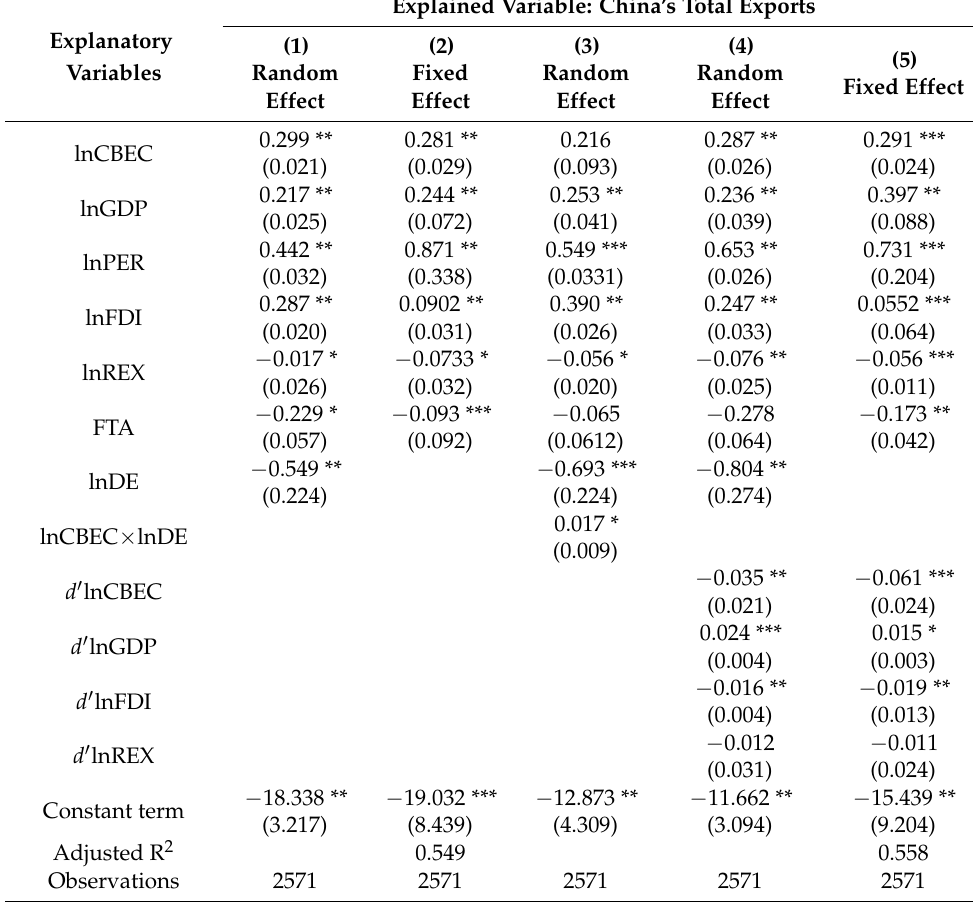
Table 3. Impact of IEC on China’s total